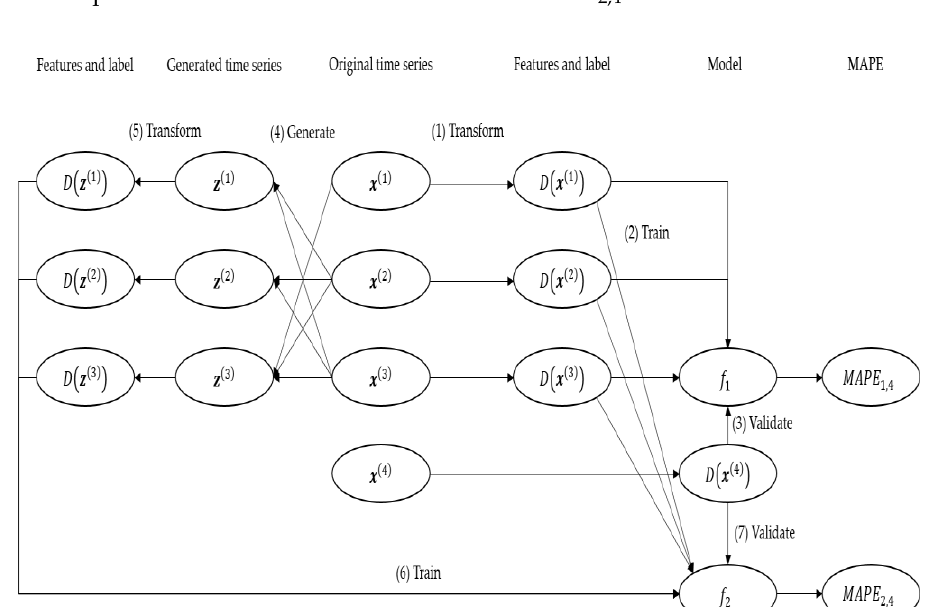
Figure 5. Example flowchart of the experimental procedure.